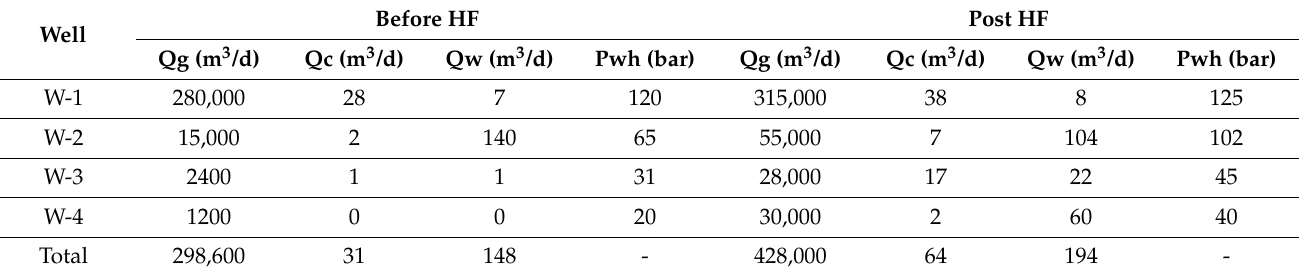
Table 17. Well production before and post